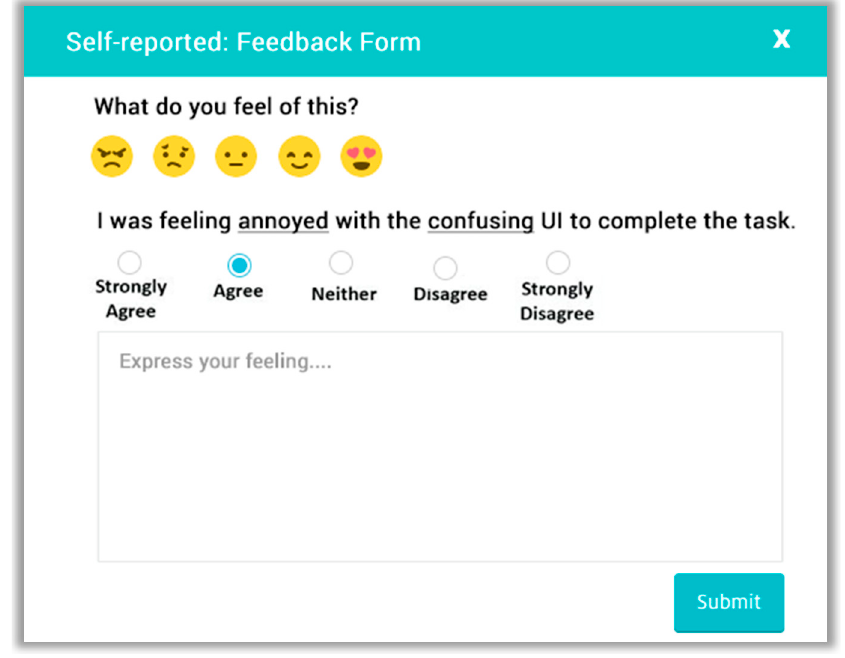
Figure 6. Self-reported feedback form.